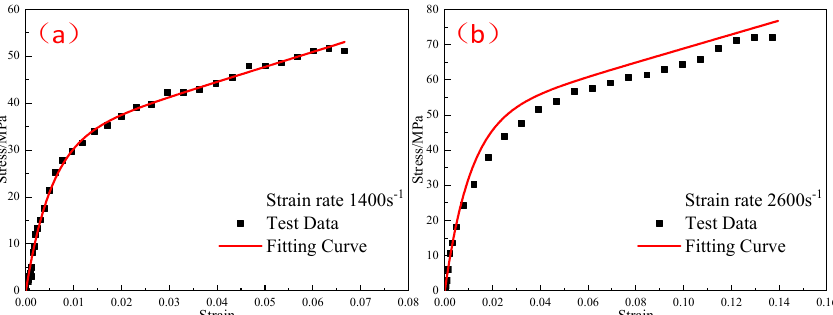
Figure 15. Comparison of the fitting results of the ZWT constitutive model with the experimental results under 600 MPa pressing pressure and at different strain rates: ( a ) 1400 s − 1 ; ( b ) 2600 s − 1 . The stress–strain curves of No.15 and No.23 with different strain rates are fitted so as to obtain the elastic constant E 2 and relaxation time θ 2 , which are suitable for strain rates ranging from 1400 s − 1 to 2600 s − 1 when the pressing pressure is 800 MPa. The fitting results are shown in Figure 16. The correlation coefficients 2 R of curve fitting are 0.98 θ and 0.99, respectively. The fitting results are 2 E = 6.3 GPa and 2 = 2.71 μ s.